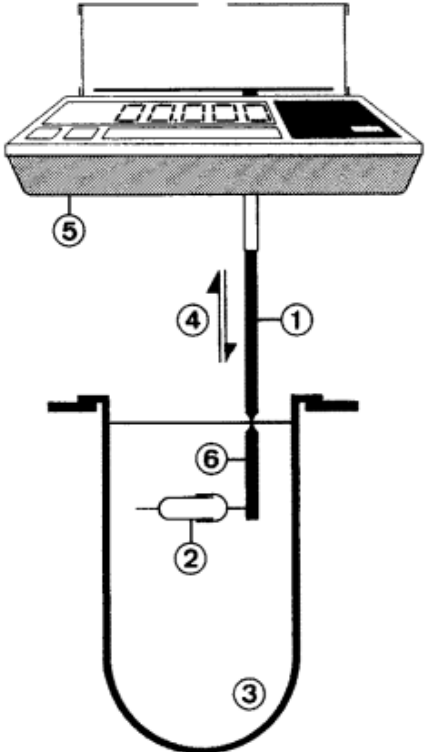
Figure 11. Schematic of the resultant-weight measurement proposed by Timmermans et al. and reprinted from Reference [75] with permission from Elsevier. Explanation of numbers as stated by the authors: (1) linear force transmitter device, (2) test object, (3) fluid medium, (4) direction of reacting force F, (5) weighing balance, (6) spit-holder